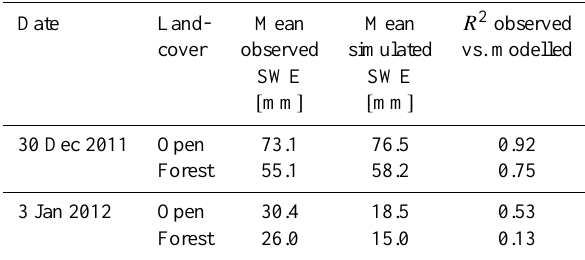
from the linear regression model with observed SWE values. Table 1. Comparison of mean SWE values derived from the cam- eras and a simple linear regression model with SWE values ob- served with a snow monitoring station